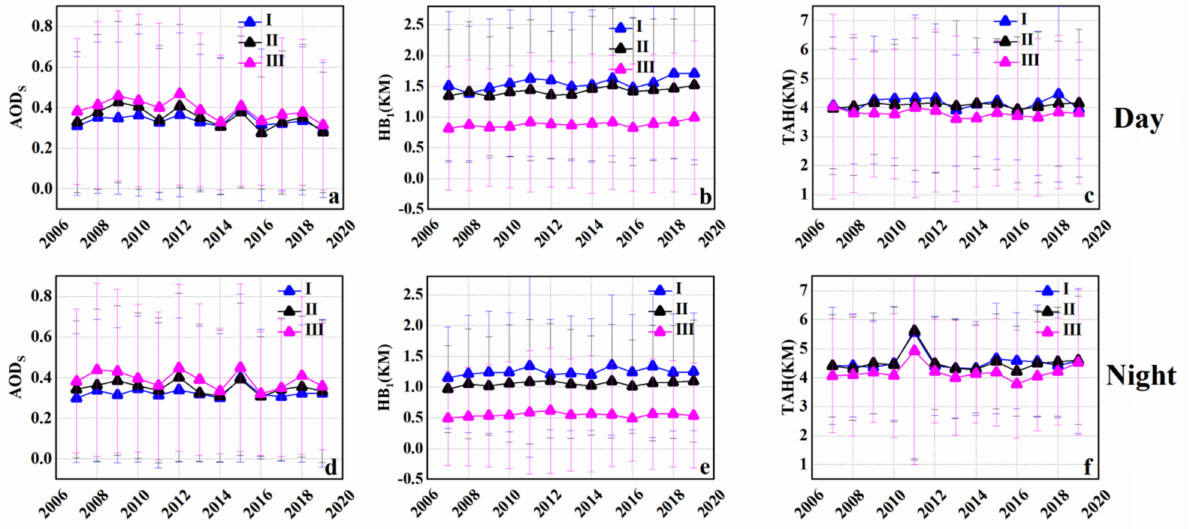
Figure 2. Interannual variations of aerosol layers over Saudi Arabia (region I, region II, and region III) from 2007 to 2019. ( a , d ) The sum of the AOD from all the aerosol layers (AOD S ), ( b , e ) the base height of the lowest aerosol layer (HB1), and ( c , f ) the top altitude of the highest Aerosol Layer (TAH). The annual mean value of AOD S was the highest in region III (daytime: 0.39 ± 0.38, nighttime: 0.39 ± 0.37), followed by region II (daytime: 0.35 ± 0.36, nighttime: 0.35 ± 0.35), and the value was the lowest in region I (daytime: 0.34 ± 0.37, nighttime: 0.33 ±